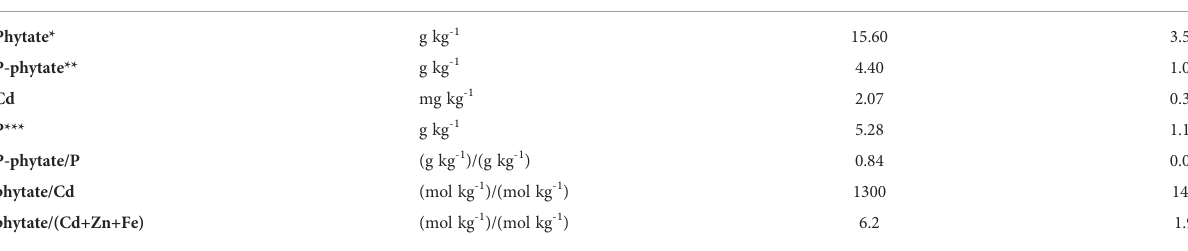
TABLE 1 Phytate and relative elemental content (DW) in the nibs ( n